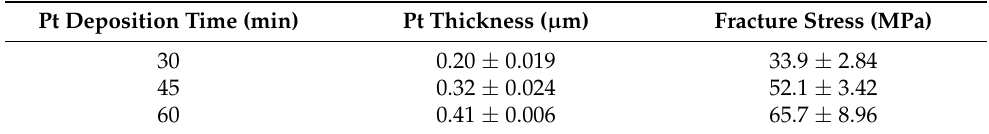
Table 1. Fracture strength of the